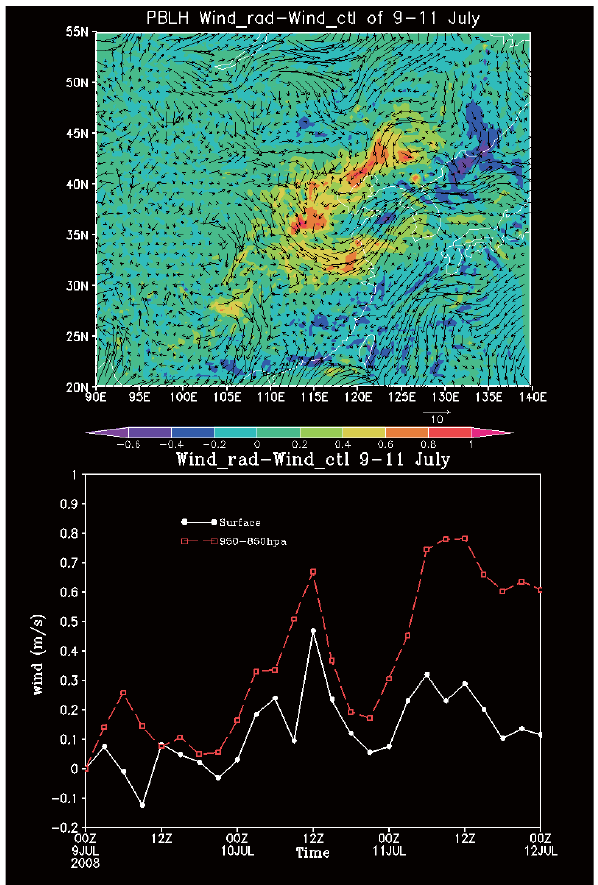
Figure 6. Wind field changes (ms − 1 ) due to aerosol DRF: (a) the mean PBL wind vector of the CTL experiment (contour) and PBL- averaged wind speed difference between the RAD and CTL experi- ments (shading) from 9 to 11 July. (b) Temporal changes of LAND- averaged wind speed difference between the RAD and CTL experi- ments at the surface and 950–850hPa height from 9 to 11